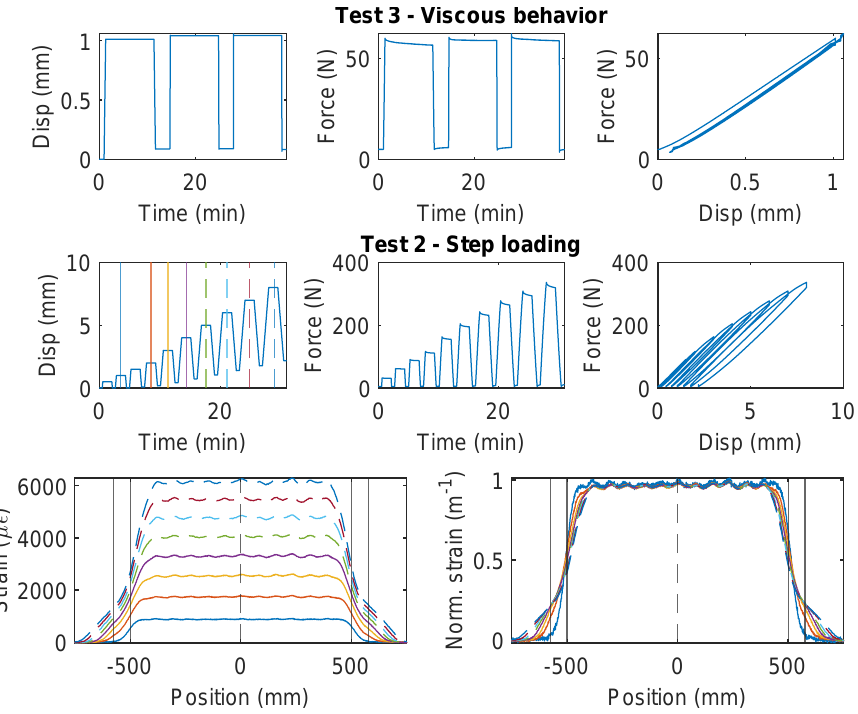
Figure 15. The loading protocol, force–displacement relation and strain distributions under increasing displacement levels (represented by different color lines) for Specimen 3 of the PA-Steel 3.2 mm